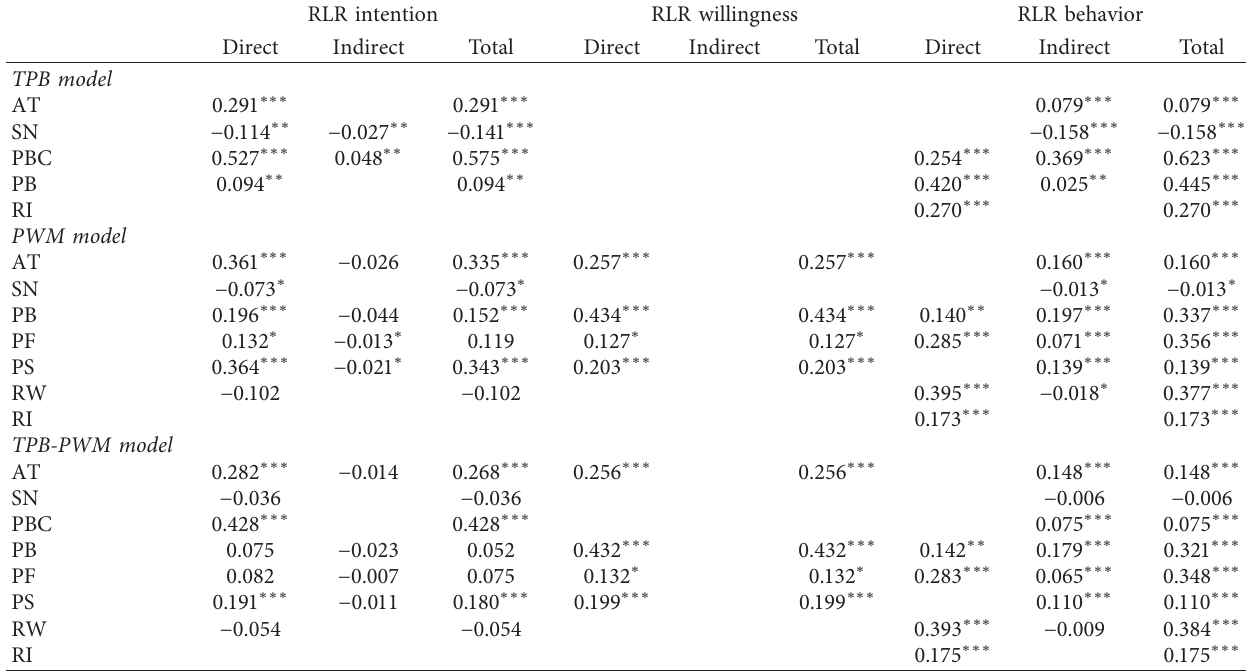
Table 4: Effects of the independent variables on RLR intention, willingness, and behavior in three